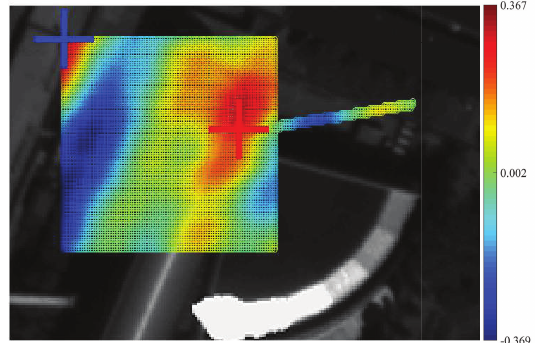
Figure 7. Histogram of the distances corresponding to Tab. 2.